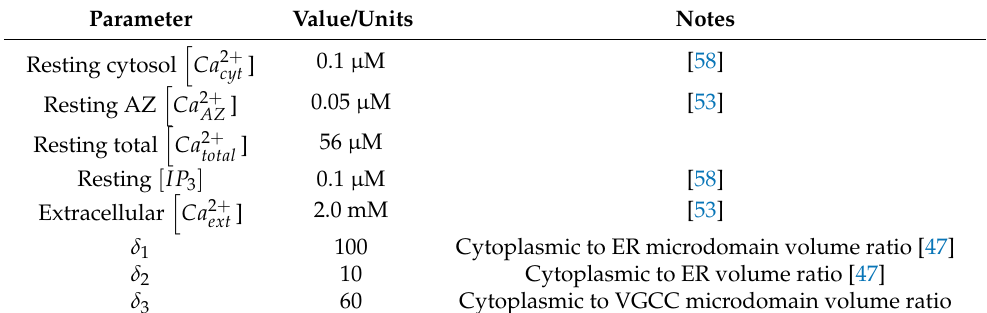
Table 3. Additional parameters used in the Ca 2+ dynamics.